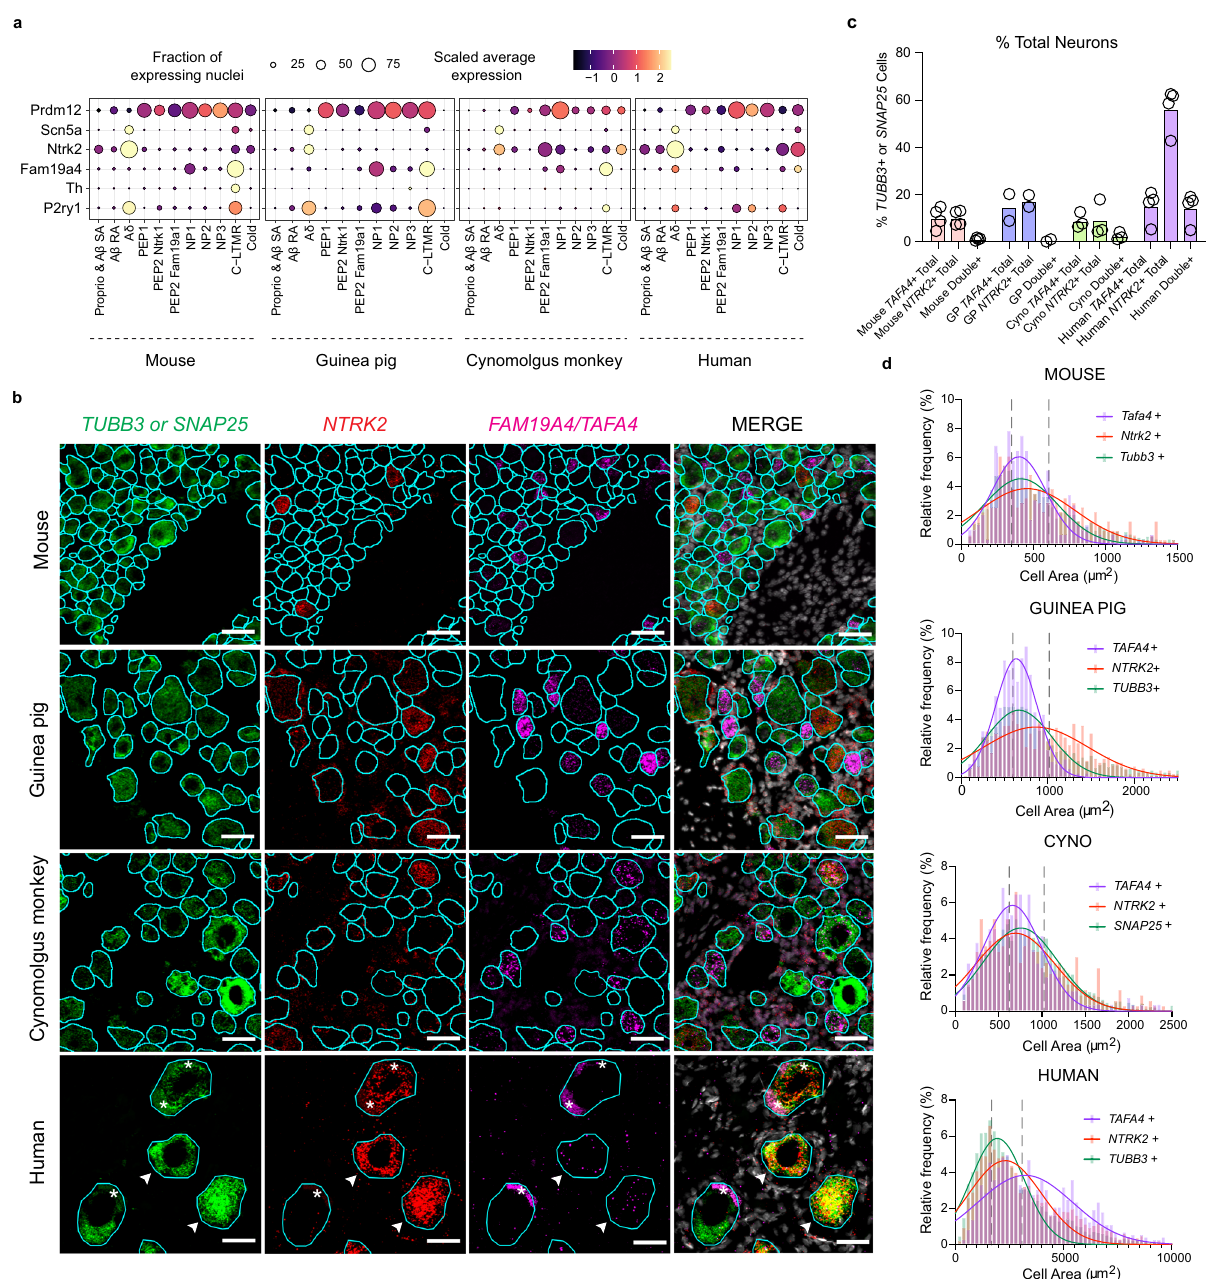
Fig. 5 | Divergent expression of TAFA4 across species. a Dot plots showing the fraction of nuclei (size) and their scaled average expression level (color) in each neuron subtype (columns) across mouse, guinea pig, cynomolgus monkey, and human for genes (row names). NP denotes non-peptidergic; PEP denotes pepti- dergic. b Representative images of RNAScope validation of FAM19A4/TAFA4, NTRK2 ,and TUBB3 (mouse,guineapig,human)or SNAP25 (cynomolgusmonkey)in DRGs. Neurons are outlined in turquoise. White arrowheads indicate neurons ( TUBB3 + or SNAP25 +) expressing both TAFA4 and NTRK2 in human samples. Asterisks in the human images represent lipofuscin aggregates. Scale bar